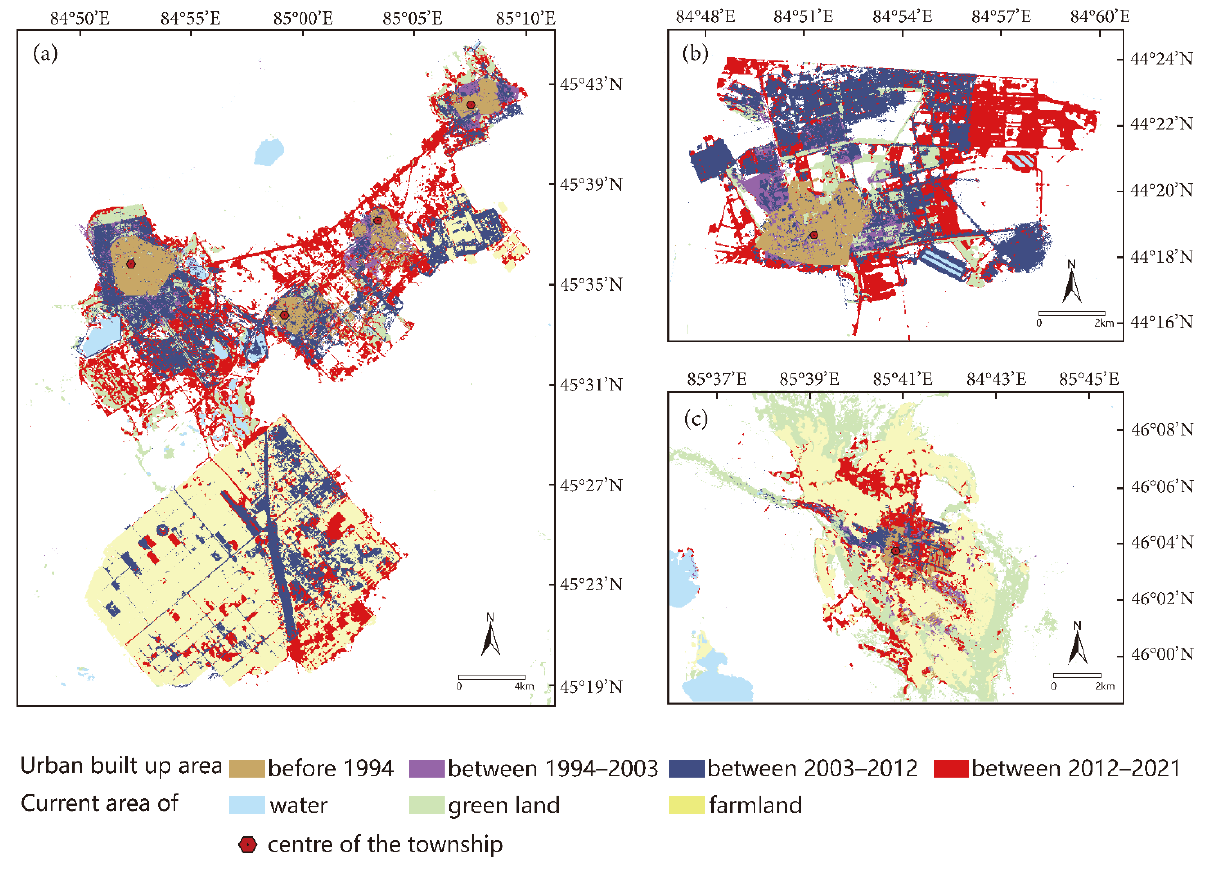
Figure 2. Distribution of land use of each township in 1994, 2003, 2012, 2021. ( a ) from left to right: Karamay, Jinlong, Sanping, and Baijiantan; ( b ) Dushanzi; ( c ) Wuerhe.